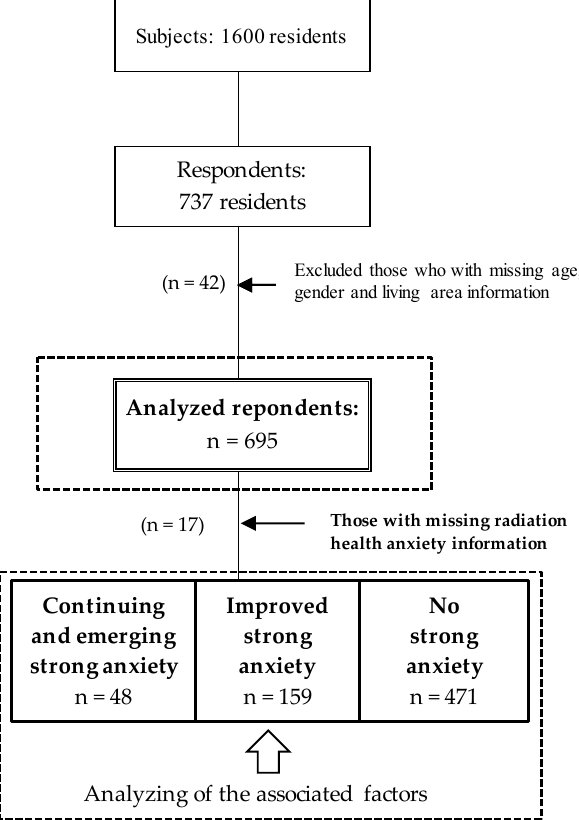
Figure 3. Sample selection and analysis of subjects in Fukushima Prefecture.